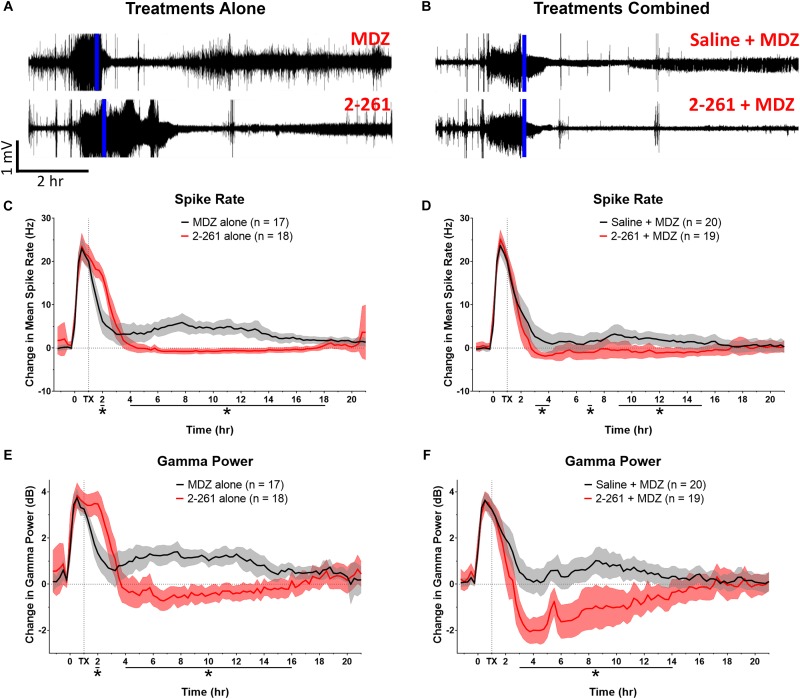
Effect of treatment by 2-261 alone or combined with MDZ after diisopropyl fluorophosphate intoxication. Representative example of EEG recordings from rats challenged with diisopropyl fluorophosphate and treated 60 min after the onset of SE (indicated by vertical blue line) with either 1.8 mg/kg MDZ i.m. alone or 120 mg/kg 2-261 i.p. alone (A). EEG traces in (B) show rats treated with saline combined with MDZ or 2-261 combined with MDZ. Summary of the change in mean spike frequency and gamma power after 2-261 treatment alone (C,E) or combined with MDZ (D,F) after diisopropyl fluorophosphate exposure. Asterisks indicate time points at which there was a significantly different response between treatment groups in spike rate or gamma power as measured by t-test, N = 17–20 rats for each treatment group. MDZ, midazolam; hr, hour; mV, millivolts; Hz, hertz; dB, decibels.